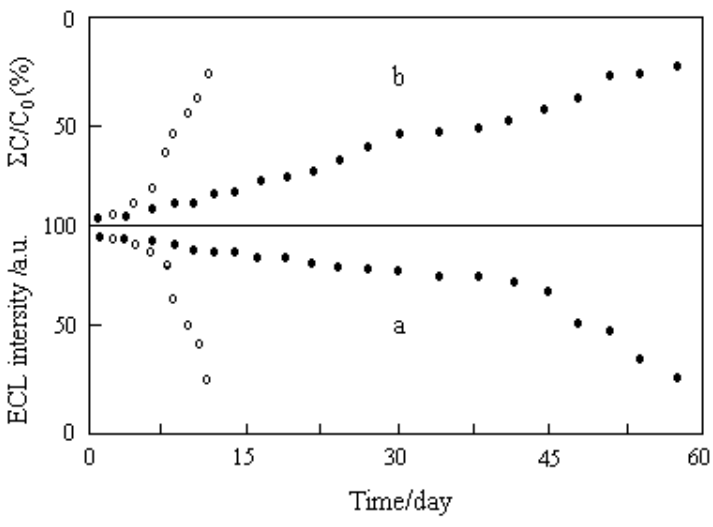
Figure 5. Decays of the responses of the probe prepared with doubly coated